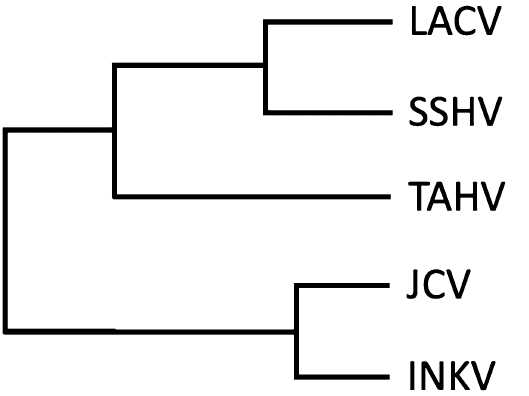
Figure 1. Schematic of genetic relationships between the CSG viruses used in this study. Figure was constructed in Microsoft Office 16